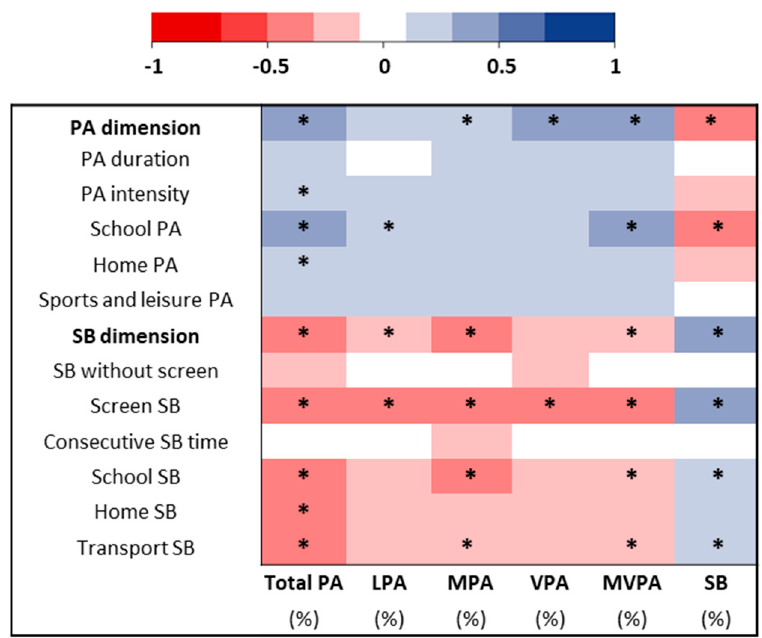
Figure 5. Heatmap representation of the correlations between physical activity (PA) and sedentary behaviors (SB) dimensions and subdomains derived from the Children and Adolescents Physical